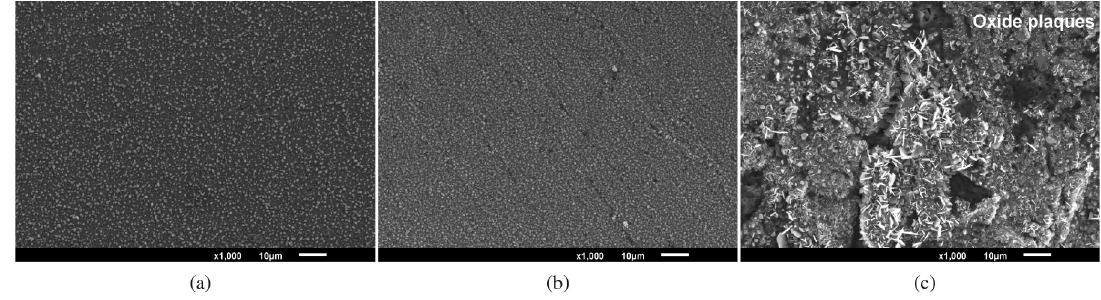
Figure 8. SEM micrographs of the: (a) bare, (b) sanded and (c) shot peening samples, after an oxidation test of 96 hours at 800°C.